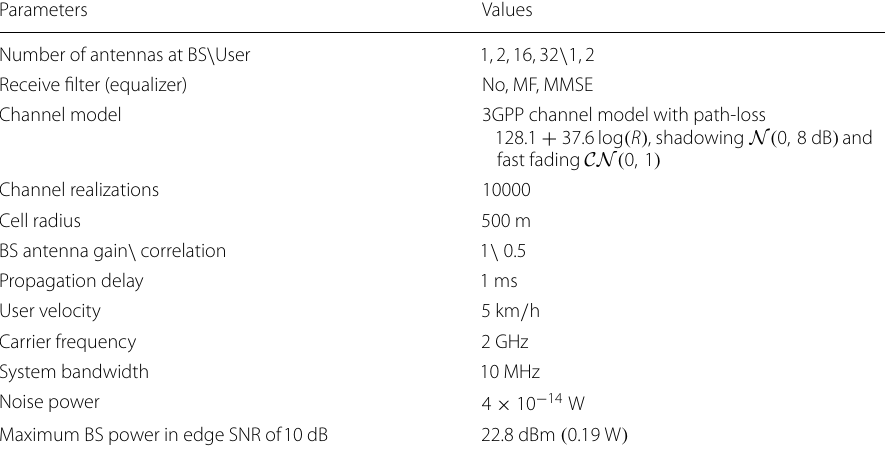
Table 2 Simulation parameters